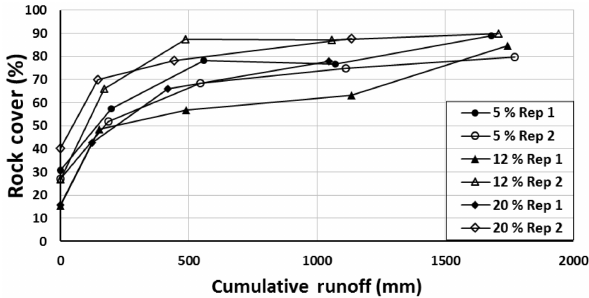
Figure 1. Plot-average rock cover (>0.5cm) as a function of cumu- lative runoff for the six